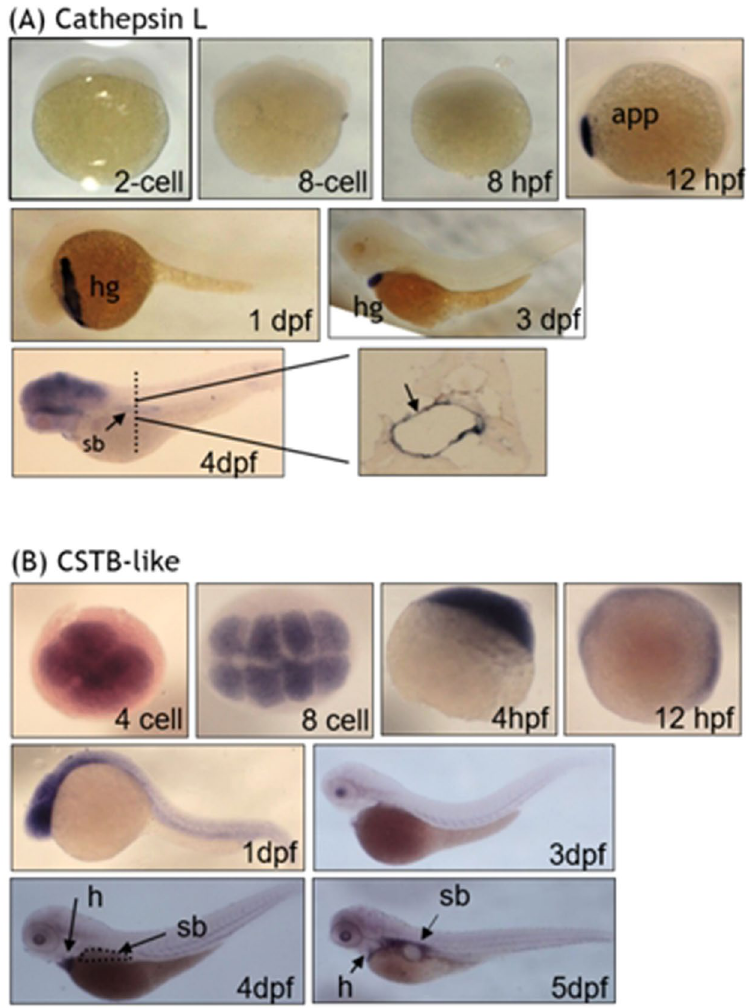
Figure 4. The expression of cathepsin L and CTSB-like during zebrafish embryogenesis. Wild-type embryos were analyzed with whole-mount in situ hybridization (WISH) at the indicated stages with antisense riboprobes against cathepsin L ( A ) and CSTB-like ( B ) for mRNA distribution. ( A ) No appreciable signal for cathepsin L was observed in embryos before 8 hpf. Signals were significant in 12 hpf embryos at anterior prechordal plate (app) and subsequently in hatching gland (hg) at later stages. Signals were also abundant in the head region and swim bladder (sb) of 4-dpf larvae, which can be observed more clearly in a post-WISH cross-section at the trunk region (dash line and black arrow in inset). ( B ) Intensive expression and homogenous distribution of CSTB-like transcripts were observed in embryos before 4 hpf. Signals became focused anteriorly in 1 dpf embryos and gradually diminished, as development proceeded, but nonetheless persistent in the trunk region along the vessels. Significant distribution appeared in the heart and the uninflated swim bladder area of 4 dpf larvae and became enriched in the region surrounding swim bladder at 5 dpf. app, anterior prechordal plate; h, heart; hg, hatching gland; sb, swim